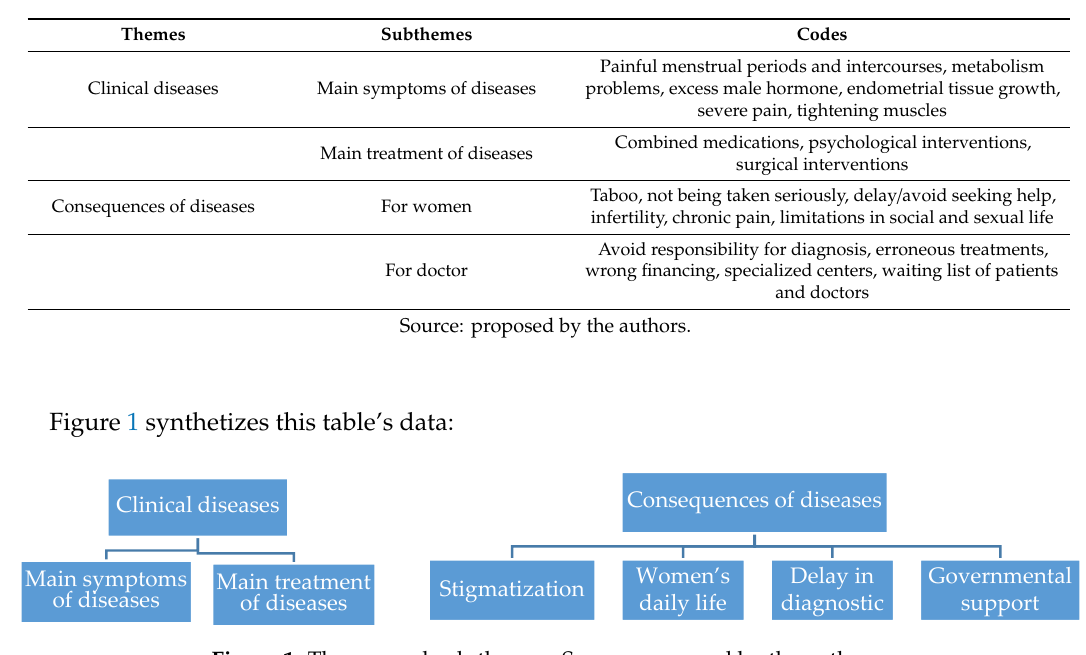
Table 4 . Themes, subthemes and codes. Table 4. Themes, subthemes and codes.